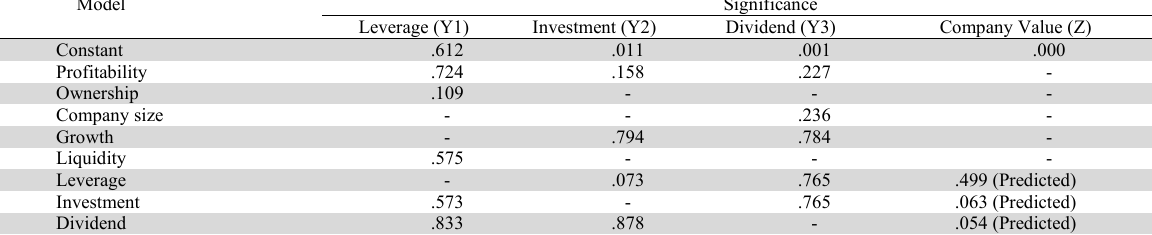
Test results of heteroscedasticity equation Leverage, Investment, Dividend, Company value Model Significance Leverage (Y1) Investment (Y2) Dividend